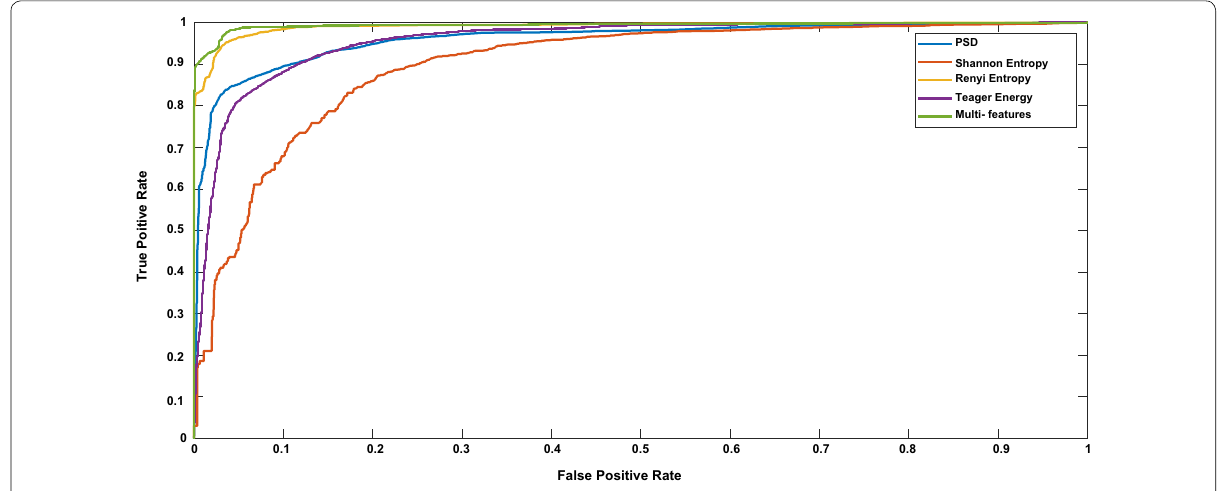
Fig. 3 ROC curve for different features obtained from EEG